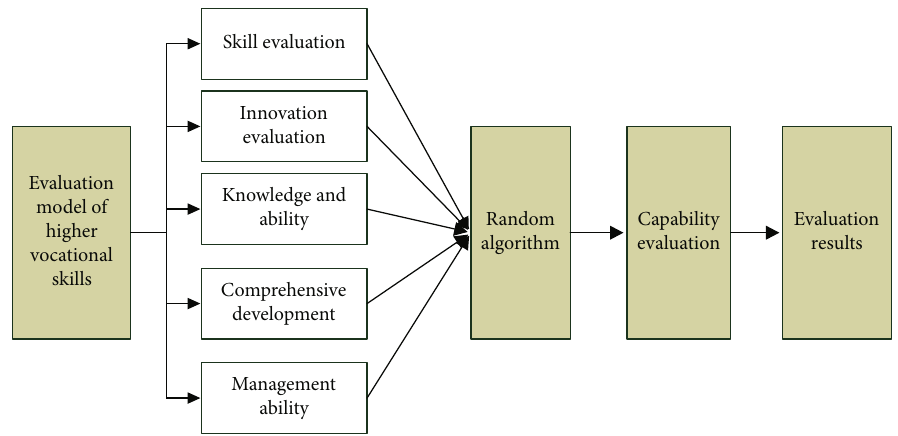
Figure 1: Evaluation model of higher vocational